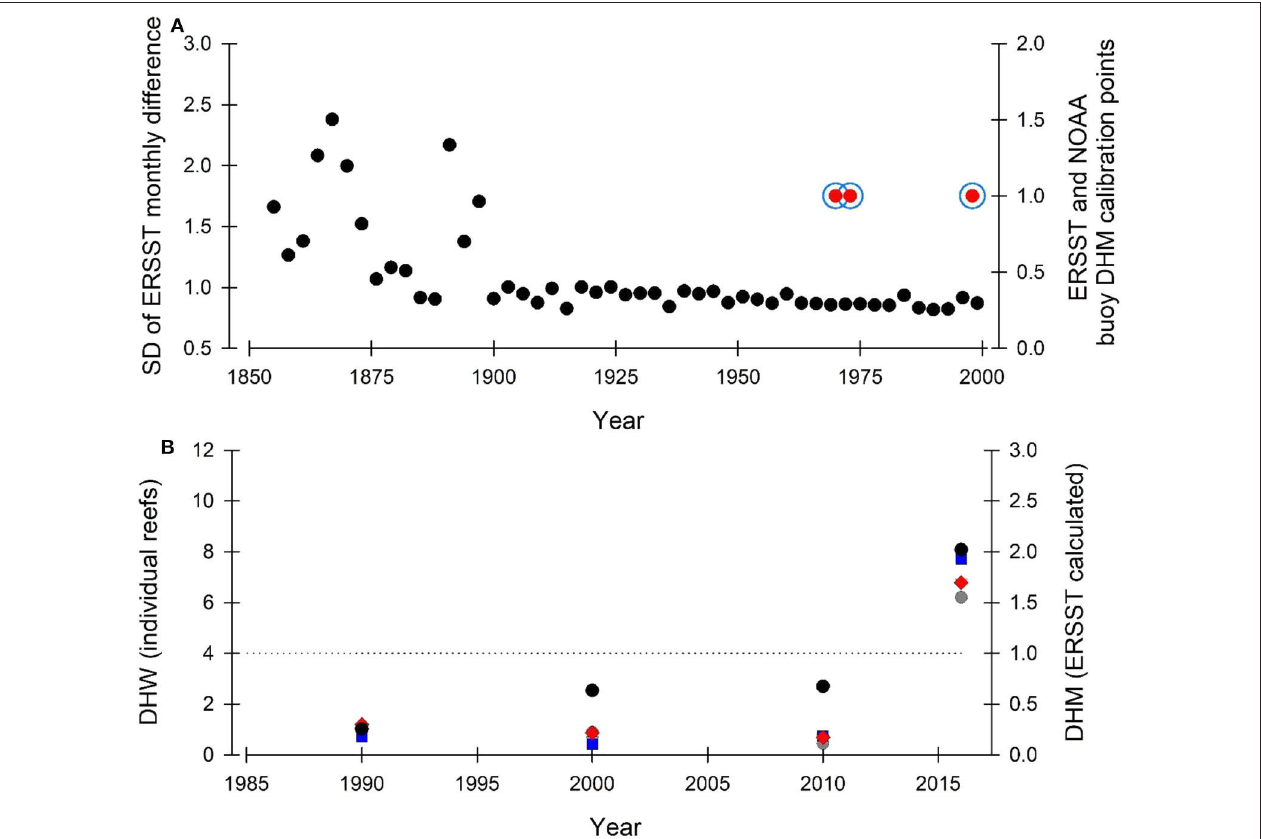
FIGURE 2 | (A) ERSST standard deviation (black dots) of temperature difference in consecutive months for three-year intervals from the same ERSST pixel (data from HG19). Temperature-derived DHM growth threshold calibrations over the period 1854-2001 are indicated for both ERSST (blue circle) and NOAA buoy data (red dots). Location of calibration years is within the lowest SD portion of the ERSST database. (B) Ability of ERSST to accurately estimate thermal stress (black dots) in comparison to ground-truthed satellite temperature [Conical Rocks (dark gray dot), Agincourt Reef (Red diamonds), Snapper Reef (Blue square), and Low Isles (light gray triangle)]. Four 5 × 5 km 2 segments within the ERSST pixel; data from HG19. Black dotted line indicates DHM (ERSST) and DHW (individual reefs) equivalence. Data presented as decadal bins (as per KH18) beginning in 1986, apart from 2016 and 2017 which occupy a single 2-year bin at the end of the time series. Both ERSST and ground-truthed satellite data predict the same bleaching responses in the context of the DHM-DHW equivalence